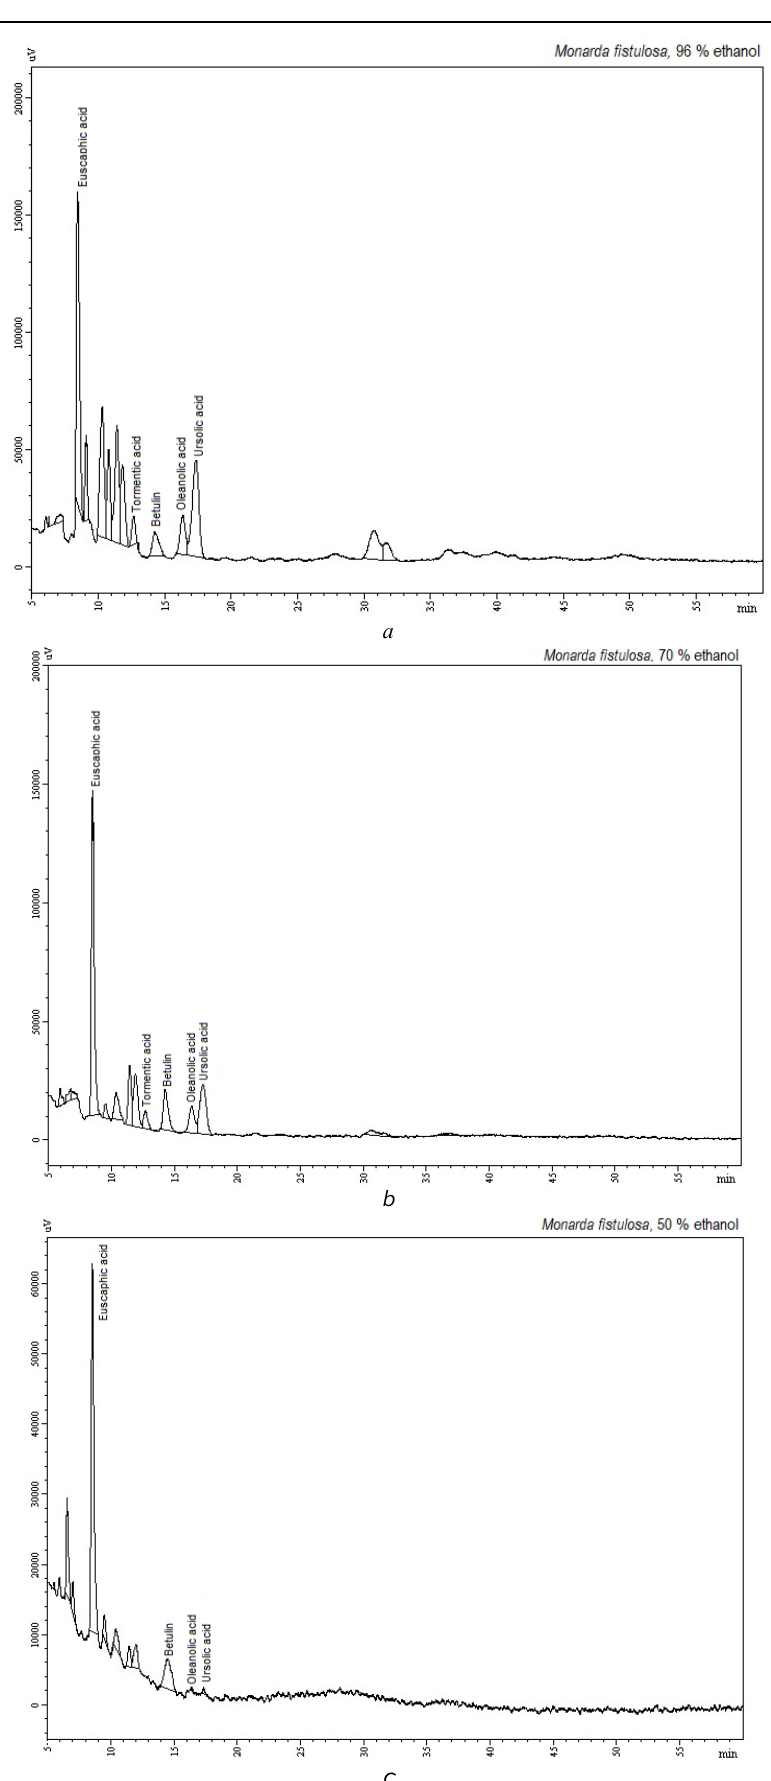
Fig. 1. Chromatogram of M. fistulosa herb extracts, obtained using ethanol of various concentrations: a – 96